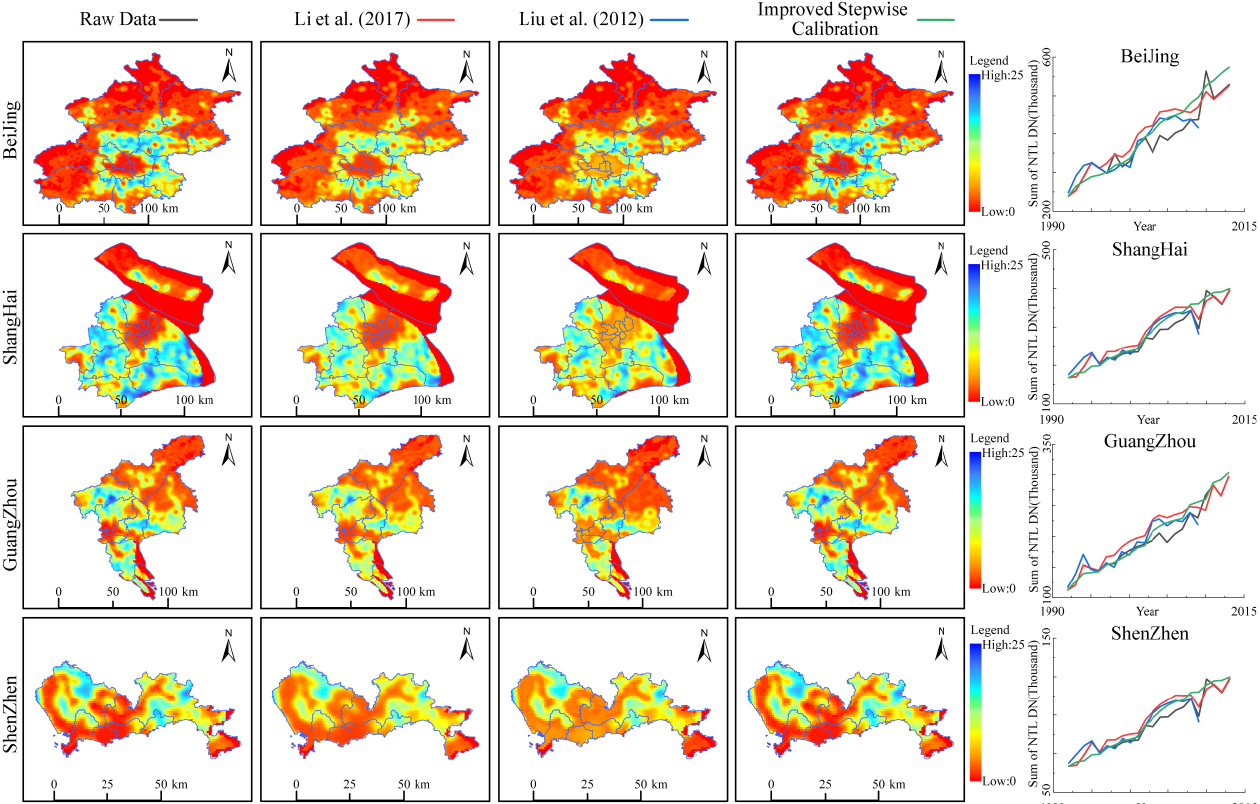
Figure 11. Standard deviation maps of three different calibration methods in typical cities.